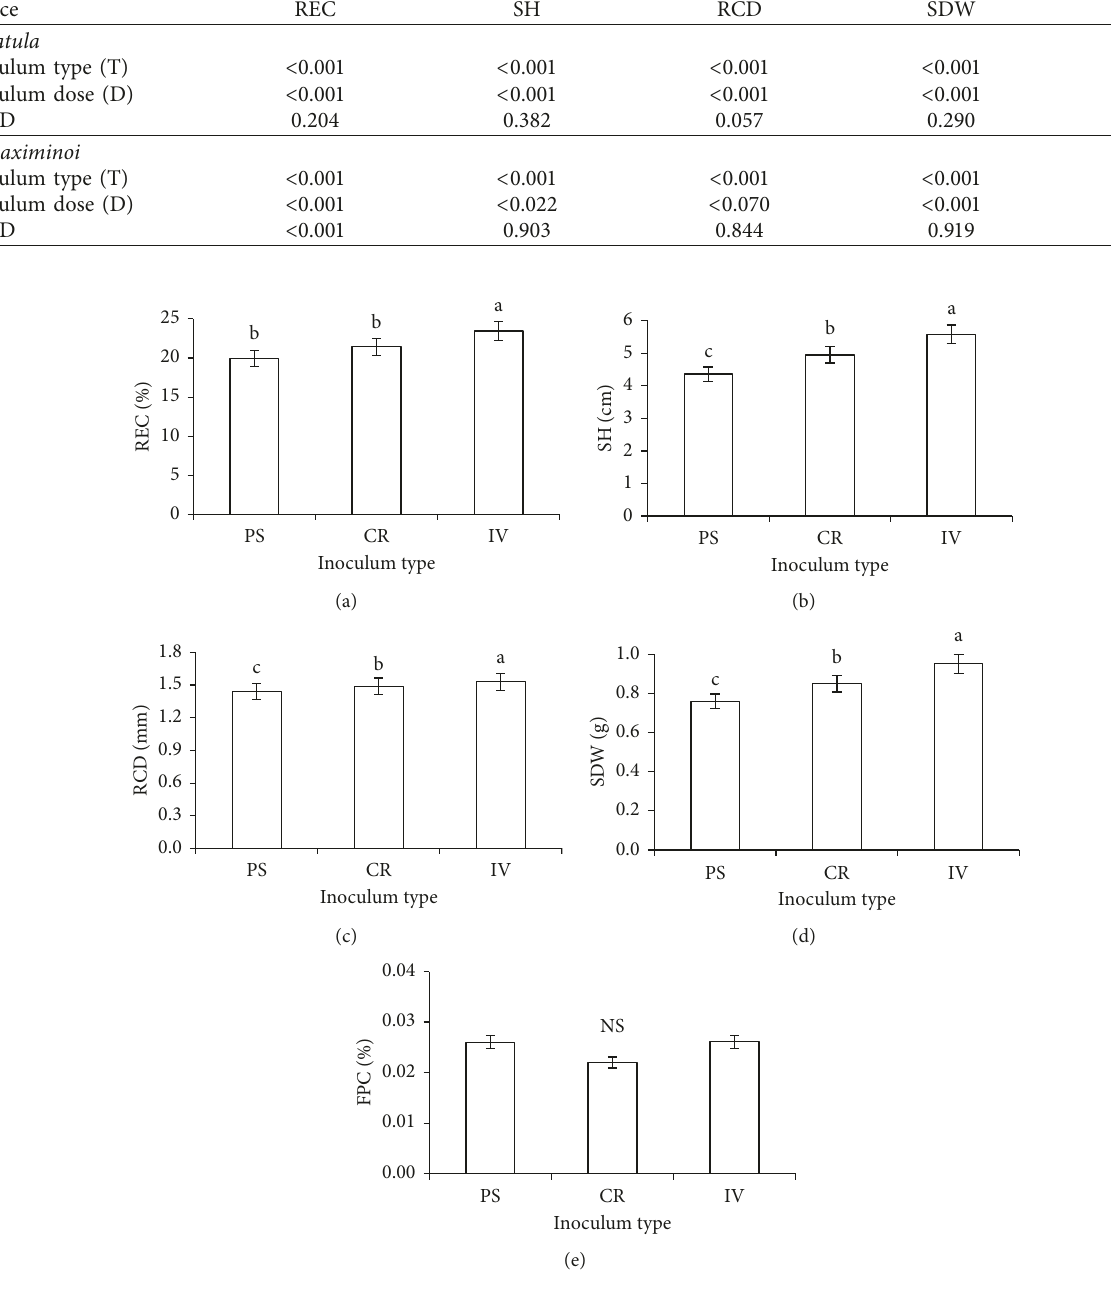
not significant. (cid:29)